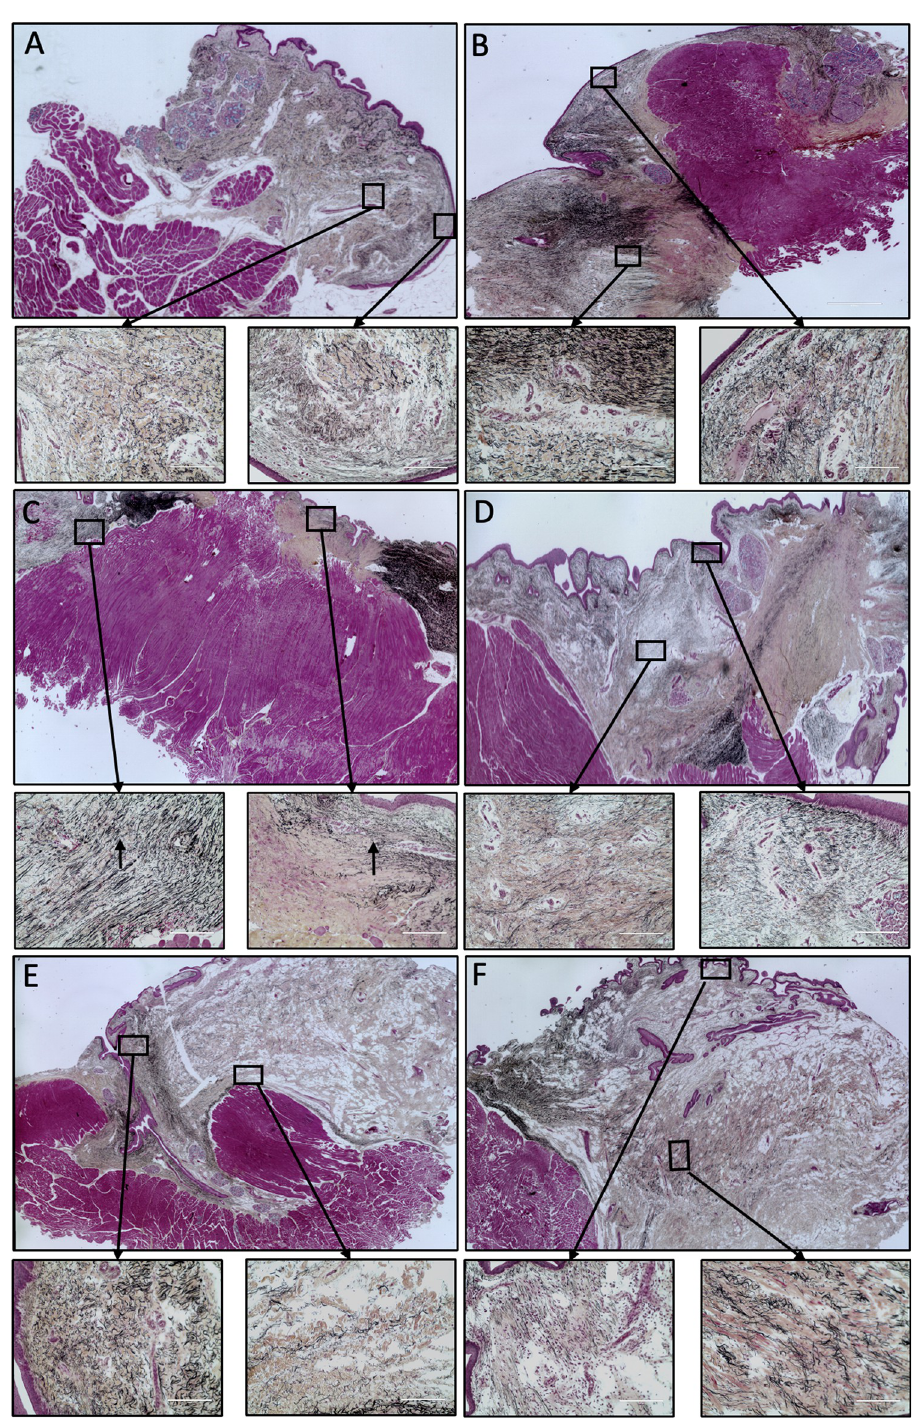
Fig 8. Movat’s pentachrome stain of porcine vocal folds 6 months after larynx surgery. Left column shows operated VF, and right column shows the contralateral unoperated VF for each (10X). Scale bars show 400 um. In all boxes, the epithelium and layers of the superficial and deep lamina propria are represented, with epithelium oriented at upper left, and thyroarytenoid muscle at lower right. A) hASC injection (pig 1); B) contralateral unoperated. C) Resected VF (scar, pig 2); D) contralateral unoperated. E) COVR implant (pig 4); F) contralateral unoperated.